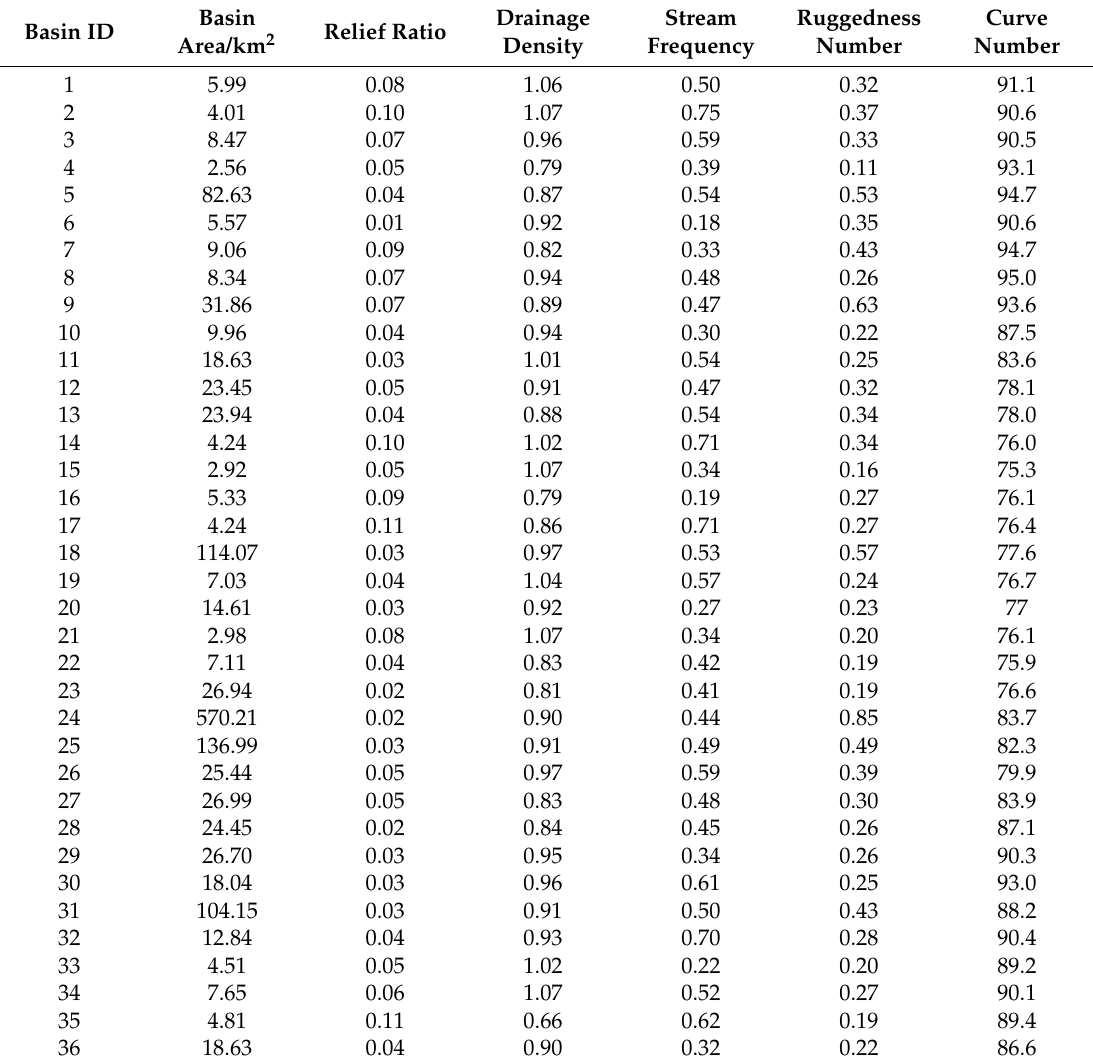
Table 1. Morphometric parameters of the sub-catchments of Wadi El-Ambagi draining toward the Qift–Quseir